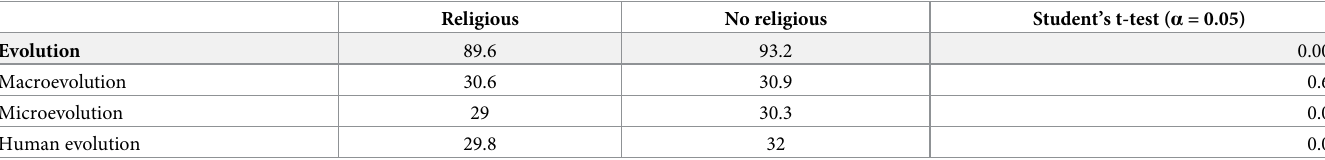
Table 3. Evolution acceptance comparison between religious and no religious